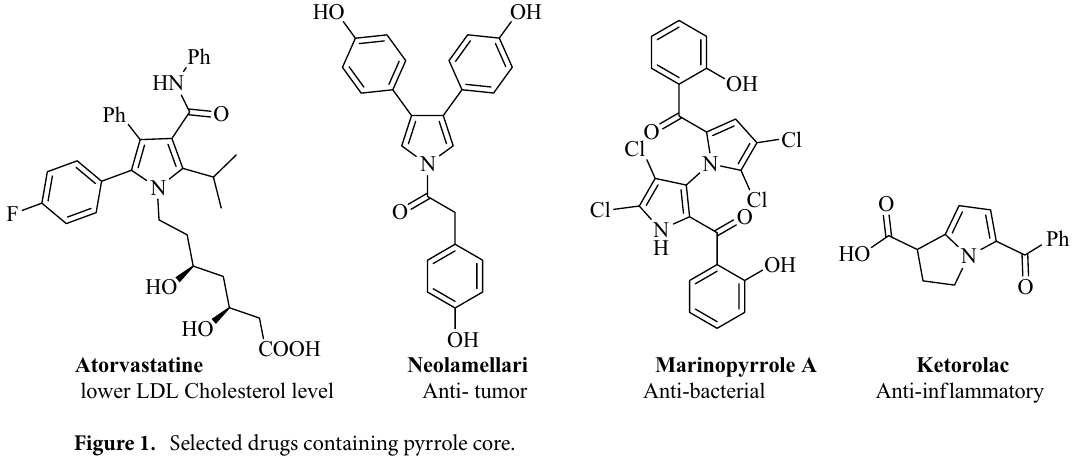
Figure 1. Selected drugs containing pyrrole